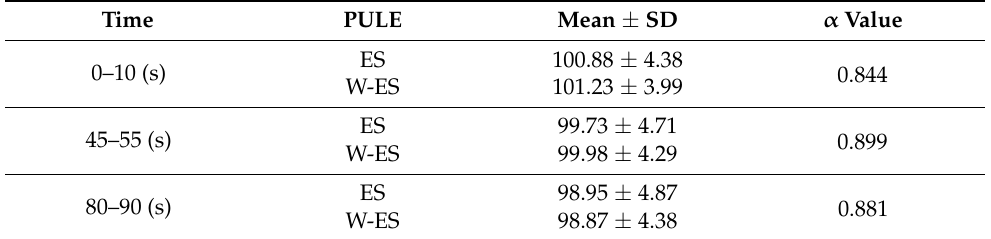
Table 3. Mean change in the lifting angle of the upper limb and α value before and after wearing the PULE for fruit thinning simulation ( n = 18).